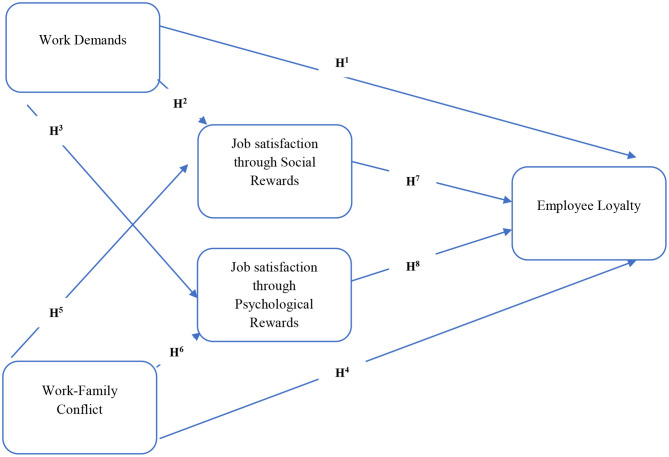
Theoretical model.